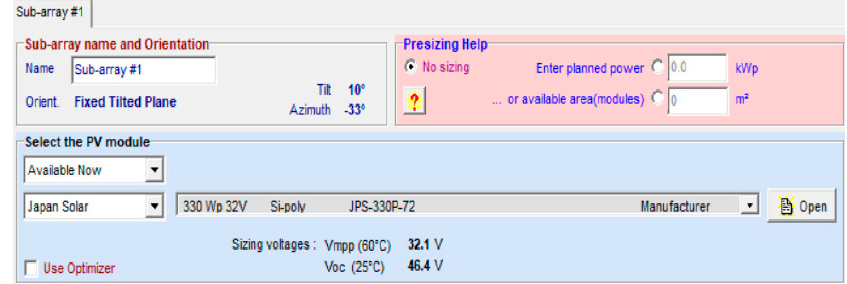
Figure 10. Configuration of roof 2 (R2) as a PVSyst unit. Table 7. Summary of the annual PV loss diagram and its unique characteristics from the 7-rooftop solar PV.